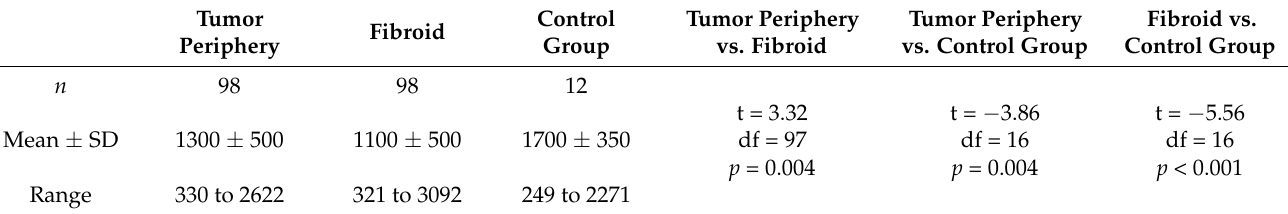
Table 1. The number of immunopositive cells—comparison between